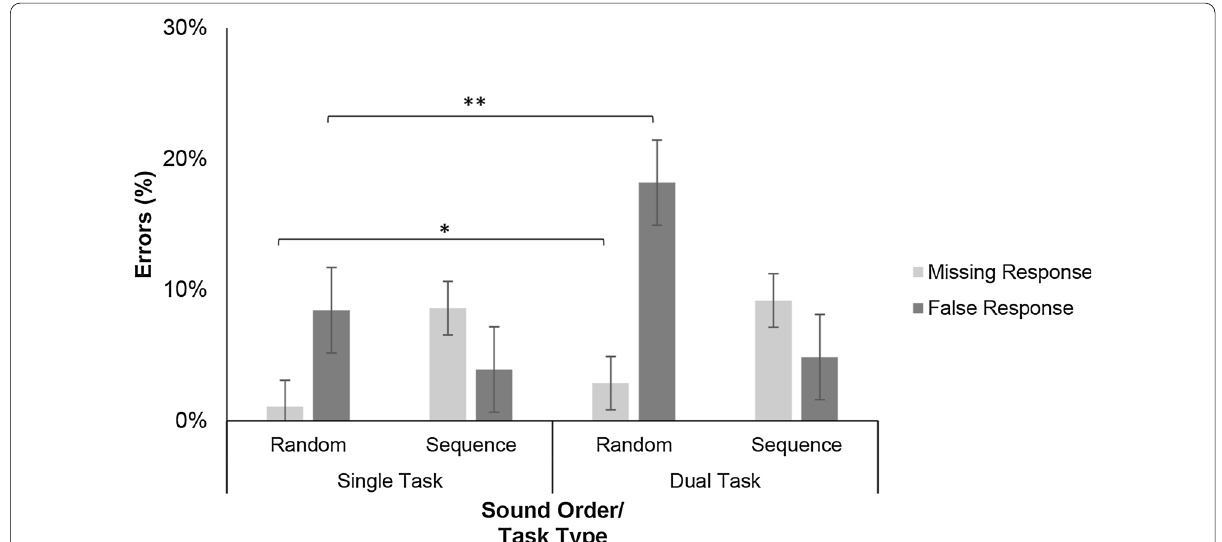
Fig. 9 Errors in Experiment 2a were either false responses to distractor sounds or missing responses. There were only significant differences between single- and dual-task conditions when sounds were random, with Err _miss , t (21) d 967, =